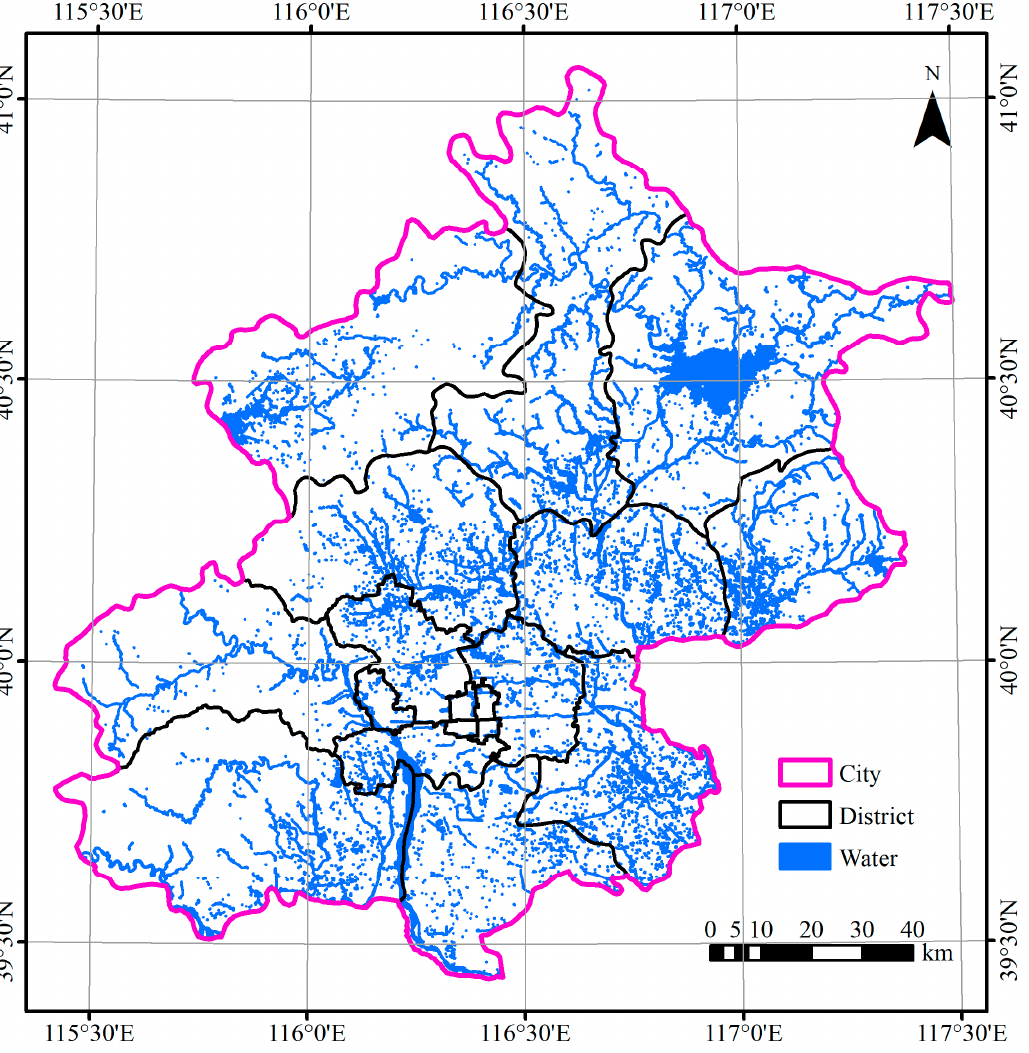
Figure 5. Surface water distribution of Beijing in 2018/2019.